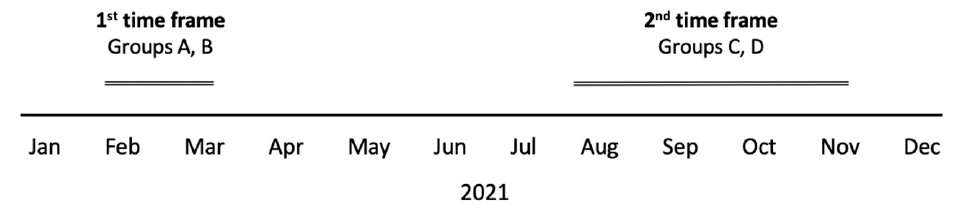
Figure 1. Study Flow Timeline Diagram. Group A “Recovered”; Group B “Second Vaccination”; Group C “Third Vaccination”; Group D “No Third Vaccination”